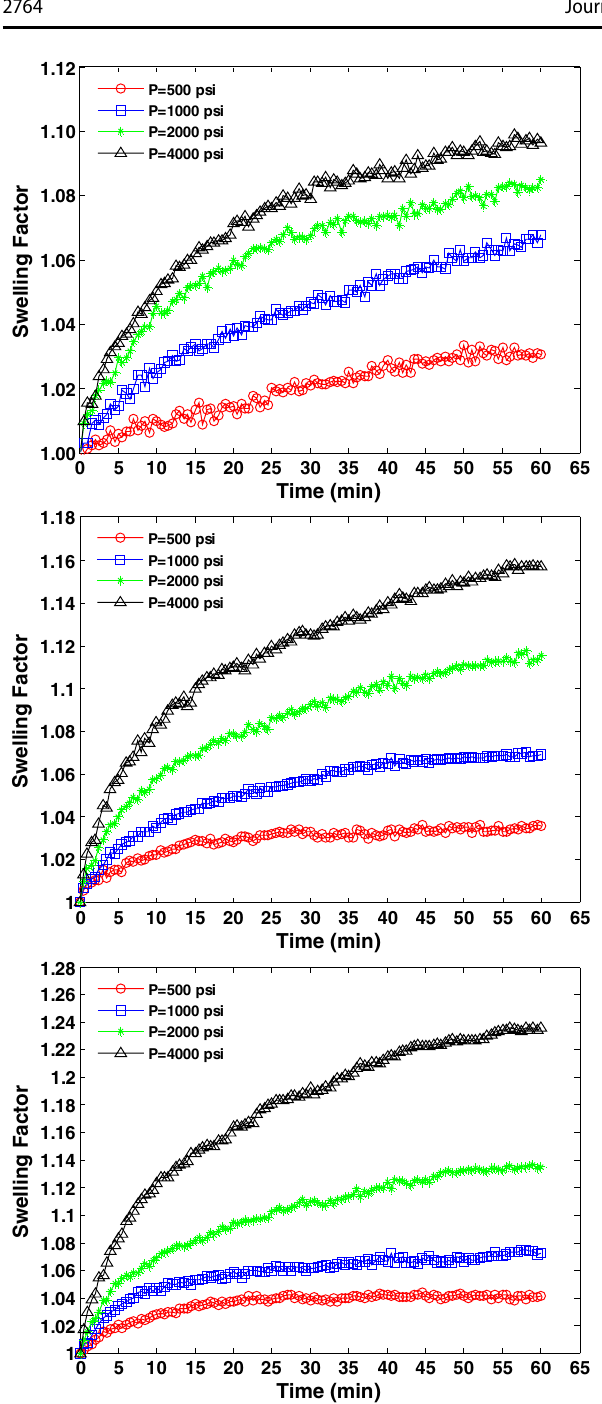
Fig. 4 Dynamic swelling factor of crude oil in the presence of 15,000 ppm of MgSO 4 at temperature of a T = 30 °C, b 50 °C, and c 80